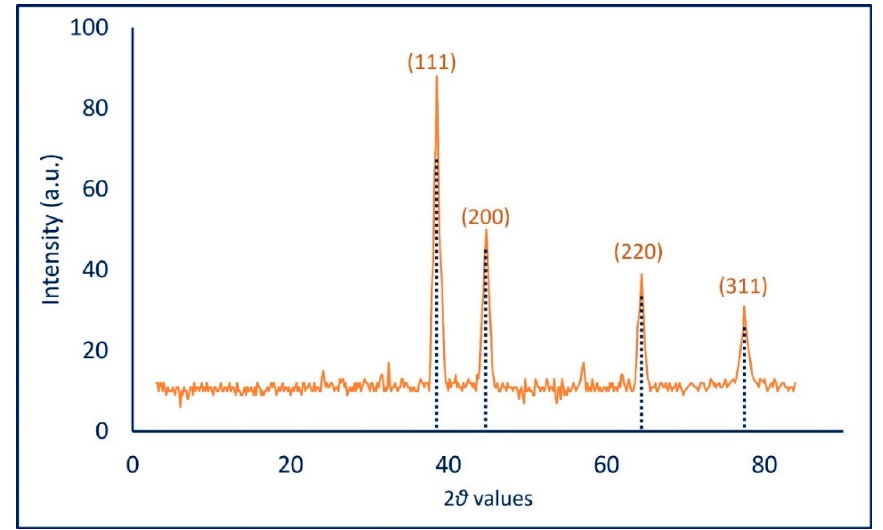
Figure 5. X-ray diffraction (XRD) analysis of Ag-NPs fabricated by A. flavus.